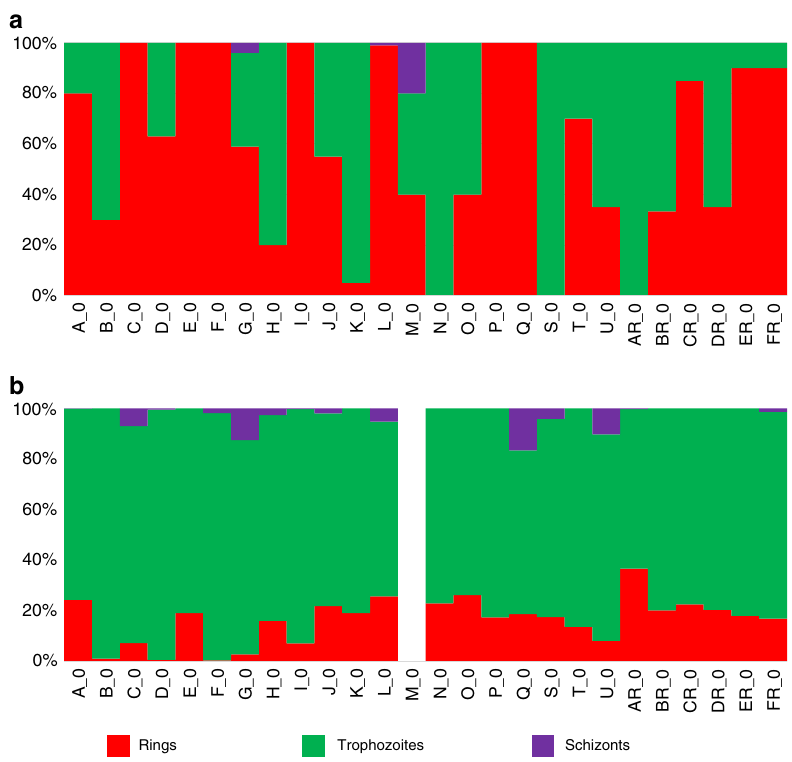
Fig. 1 P. vivax stage composition of all clinical infections. Each vertical bar represents one clinical infection and is colored according to the proportion of schizonts (purple), trophozoites (green and blue), and rings (red). The top panel displays the stage composition determined by microscopy ( a ) while the bottom panel shows the stage composition inferred from gene expression deconvolution of the same infections ( b ). (The gene expression deconvolution for the M infection was not successful and is not